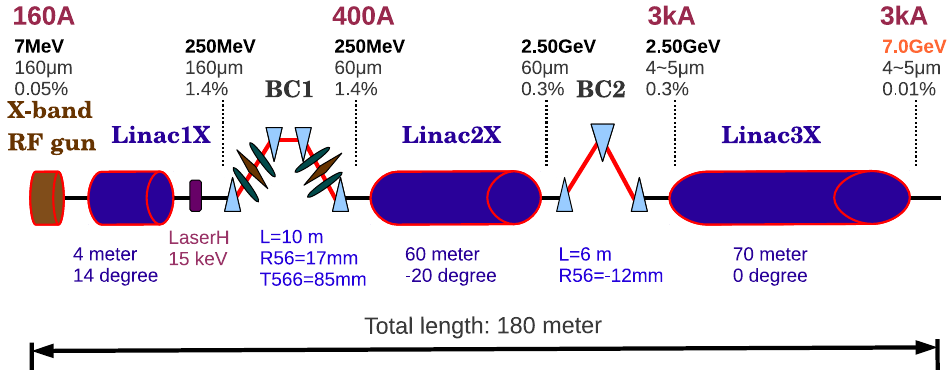
FIG. 1. Sketch of an all X-band based hard X-ray FEL accelerator design (BC1 is sketched as a chicane shape